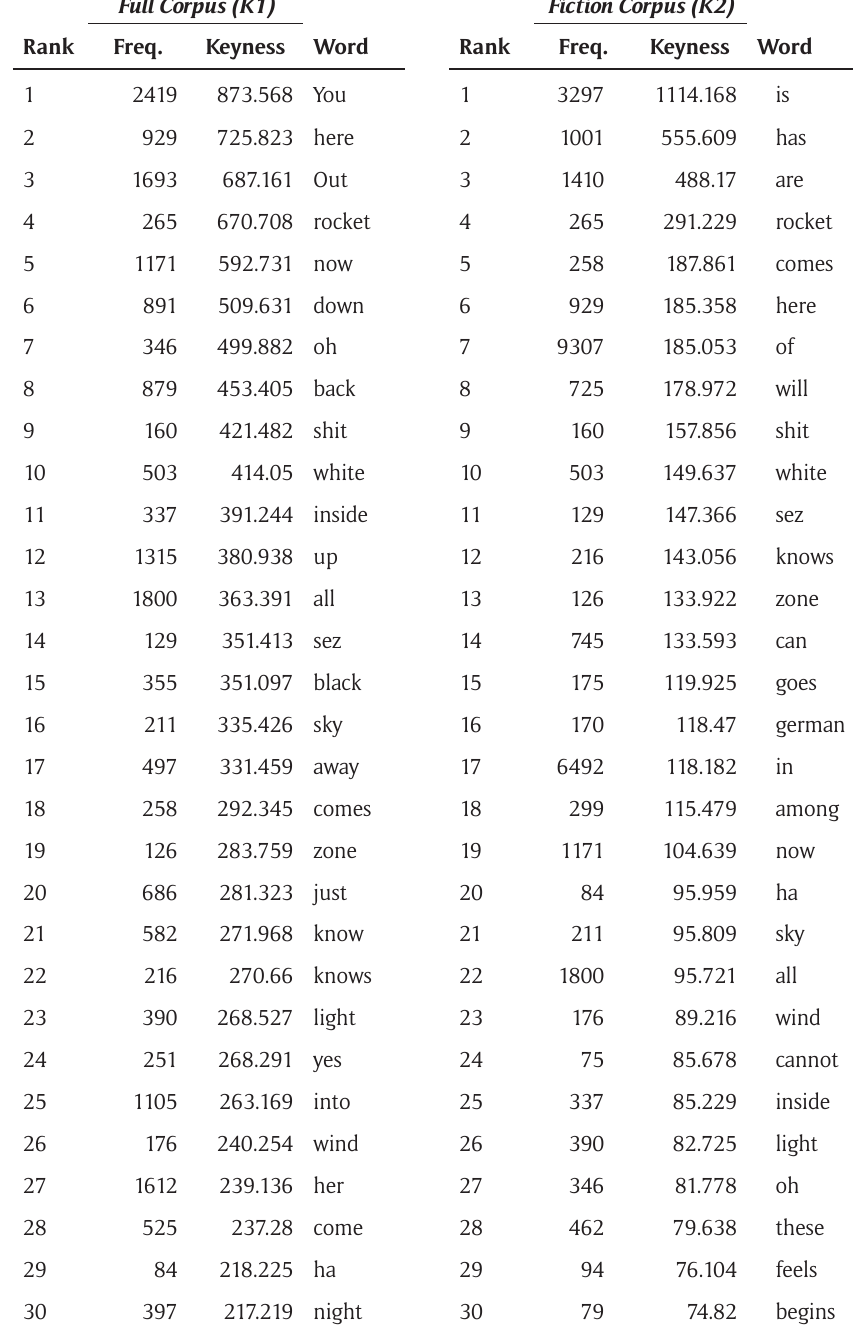
Table 1: Keyness Measures for Gravity’s